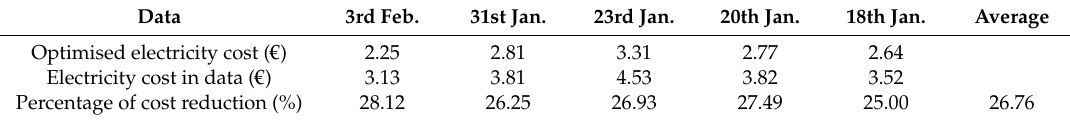
Table 3. Summary of results of the improved QPSO for five cold winter days in